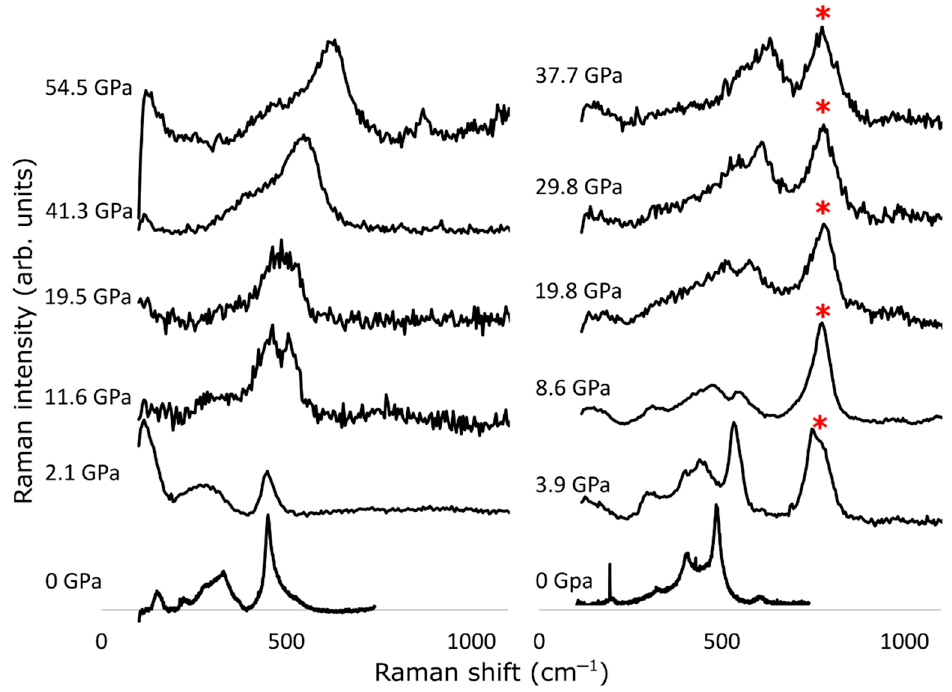
Figure 5. Raman spectra of Na 2 AgF 4 ( left ) and Rb 2 AgF 4 ( right ) measured with 514 nm laser at increasing pressure; the pressure values are labelled next to each spectrum. Red asterisks indicate bands originating from FEP used as pressure medium.